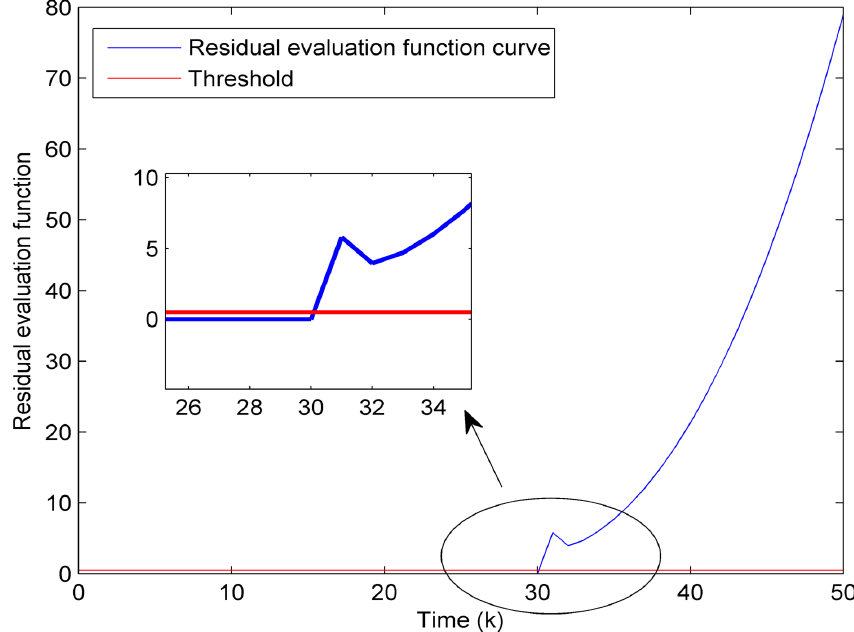
Figure 4. The residual evaluation function responses of the system with zero ˜ d k for a sudden-changing fault (Equation